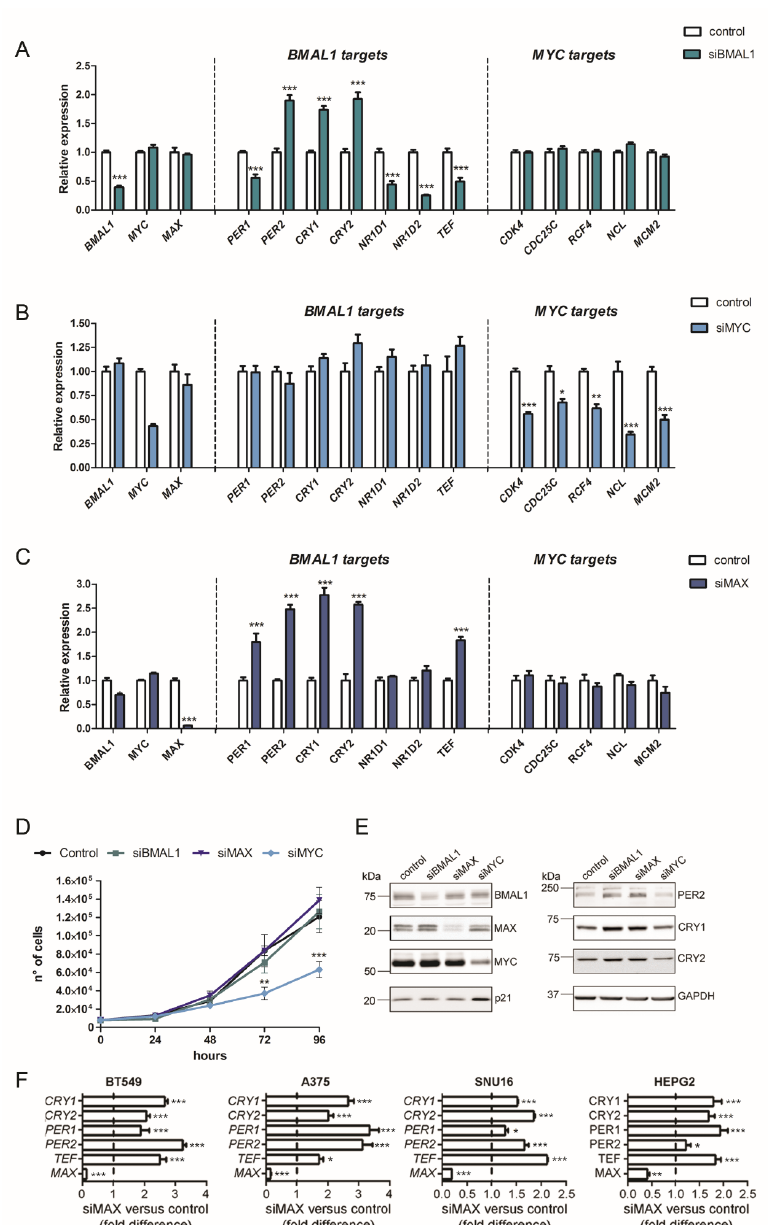
Figure 1. Knockdown of MAX alters the expression of core clock genes. ( A – C ) Expression of the 79 circadian BMAL1 targets and the cell cycle MYC targets in MDA-MB-231 with knocked down BMAL1 (siBMAL1), MYC (siMYC), or MAX (siMAX). A non-coding siRNA was used as control. Relative expression was determined by qRT–PCR using GAPDH for normalization. The values of control cells were set to 1. Shown as mean ± SEM, n ≥ 6. * p < 0.05. ** p < 0.01 and *** p < 0.001, two-way ANOVA with Bonferroni post hoc test, silencing versus control. ( D ) Growth curve of MDA-MB-231 transfected with siRNA sequences against BMAL1 , MYC , MAX , or a non-targeting control. Shown as mean ± SEM, n ≥ 6. ** p < 0.01 and *** p < 0.001, two-way ANOVA with Bonferroni post hoc test, siMYC versus control. ( E ) Immunoblot of protein samples from siBMAL1, siMYC, siMAX, and control MDA-MB-231 cells with specific antibodies against the indicated proteins. GAPDH was used as a loading control. ( F ) The expression of MAX , CRY1 , CRY2 , PER1 , PER2 , and TEF was analyzed in breast (BT549), skin (A375), stomach (SNU16), and liver (HEPG2) cancer cell lines knocked down for MAX . The values of control cells were set to 1 (dotted line). Shown as mean ± SEM, n = 3. * p < 0.05 and *** p < 0.001, two-way ANOVA with Bonferroni post hoc test, siMAX versus